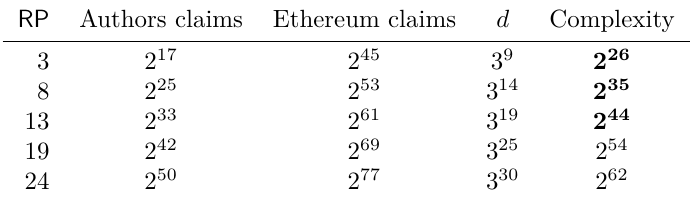
Table 2: Complexity of our attack against Poseidon , compared with the security claims given by the authors and by the challenges, with RF = 8. Complexity figures in bold correspond to attacks that we have implemented in practice.